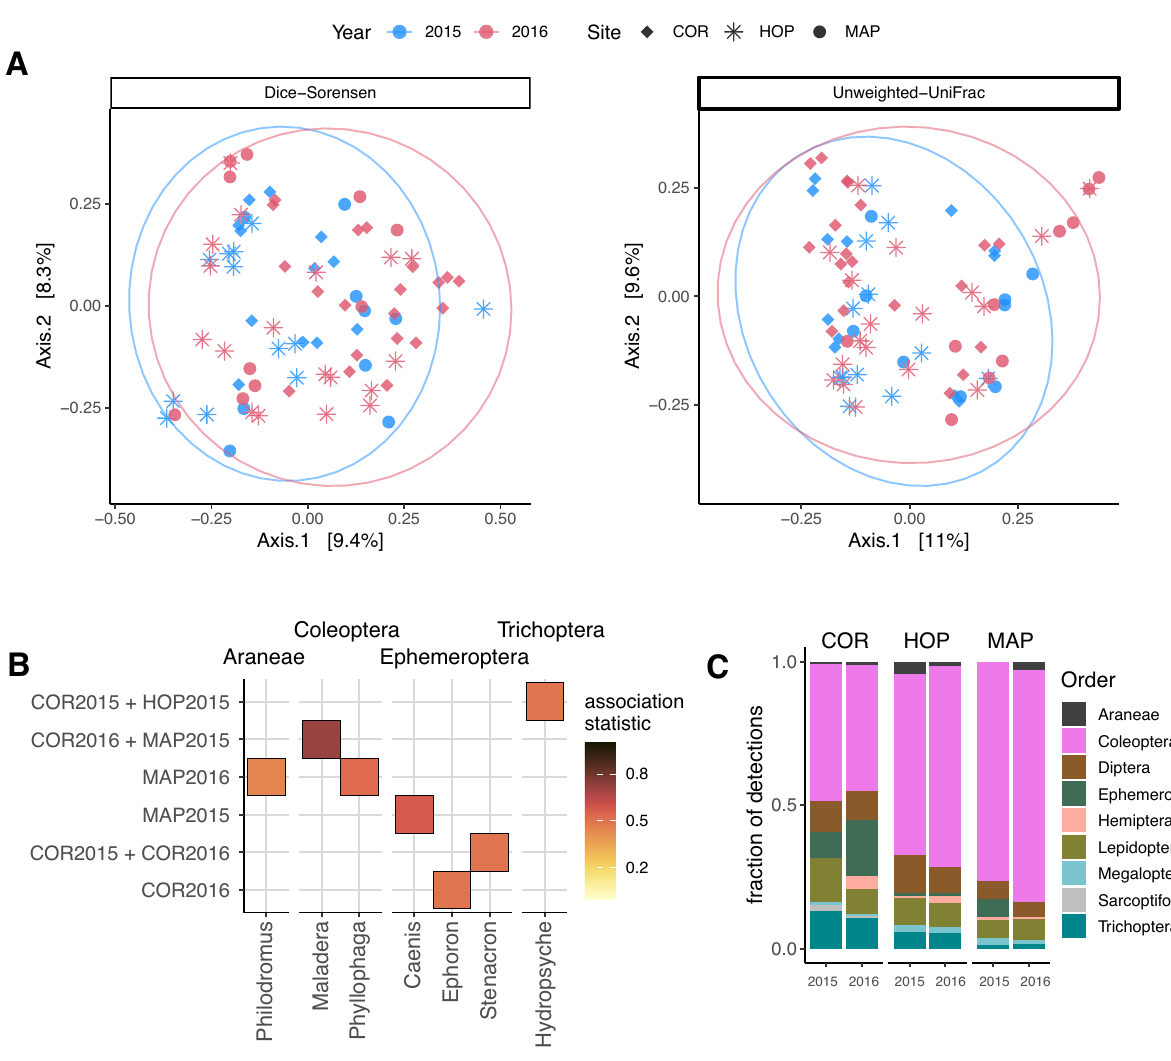
Figure 5. Changes in bat diet arthropod composition at multiple sites in a single sampling window between years 2015 and 2016. ( a ) PCoA ordinations shown for Dice-Sorensen index and unweighted UniFrac distance metrics depict sampling site (point shape) and sampling year (color); ellipses depict 95% confidence intervals around year group median. ( b ) Indicator species analysis performed at genus level to identify taxa associated with one or more site + year groups. ( c ) The proportion of taxa detected per arthropod order in each site + year